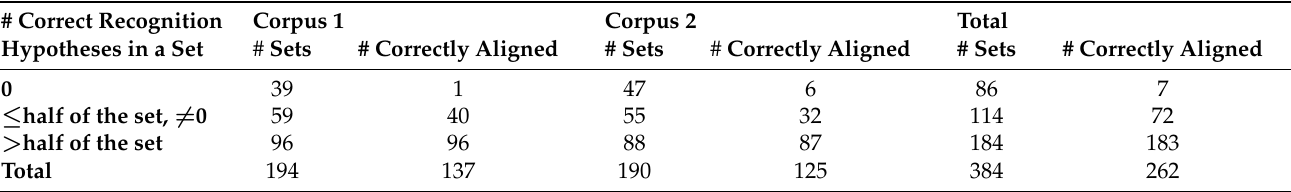
Table 4. An overview of image frame